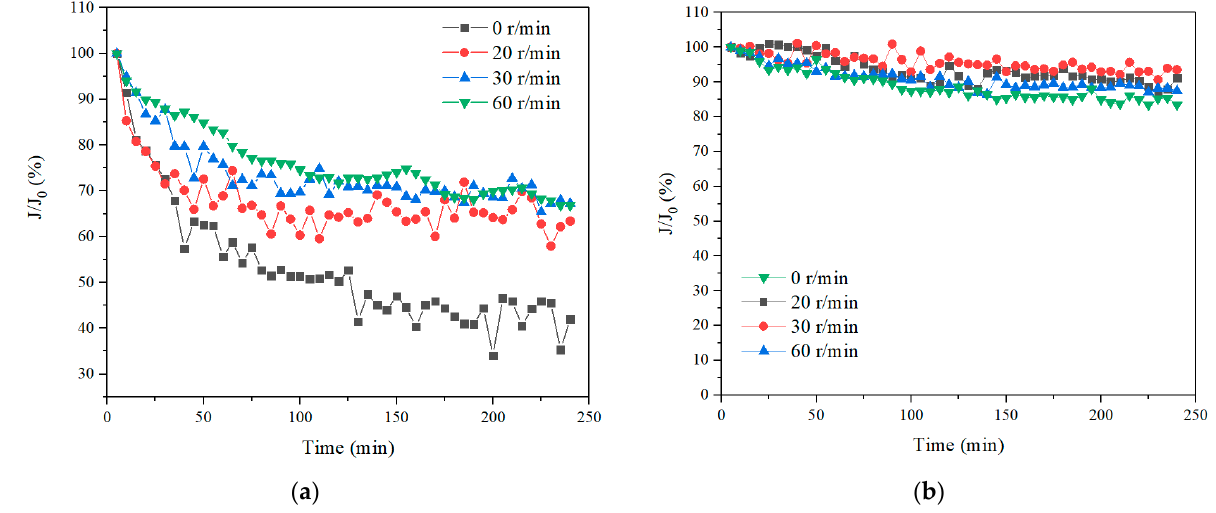
Figure 3. Permeate flux with different rotation speeds, ( a ) SA, and ( b ) TA. The TOC of the permeate with different rotation speeds and different sampling in- tervals for both SA and TA solutions were measured and the results are presented in Figure 4. In the SA solution, the TOC removal was very low, i.e., ~40% without membrane rotation. With 20 r/min membrane rotation, the TOC removal ratio increased to ~55%. When the membrane rotation speed increased to 30 r/min, the TOC removal ratio increased significantly to ~75%. With the additional increase of the membrane rotation speed to 60 r/min, the TOC removal ratio maintained nearly the same as that with 30 r/min rotation. In contrast, in TA solution, the TOC removal ratios maintained nearly the same,